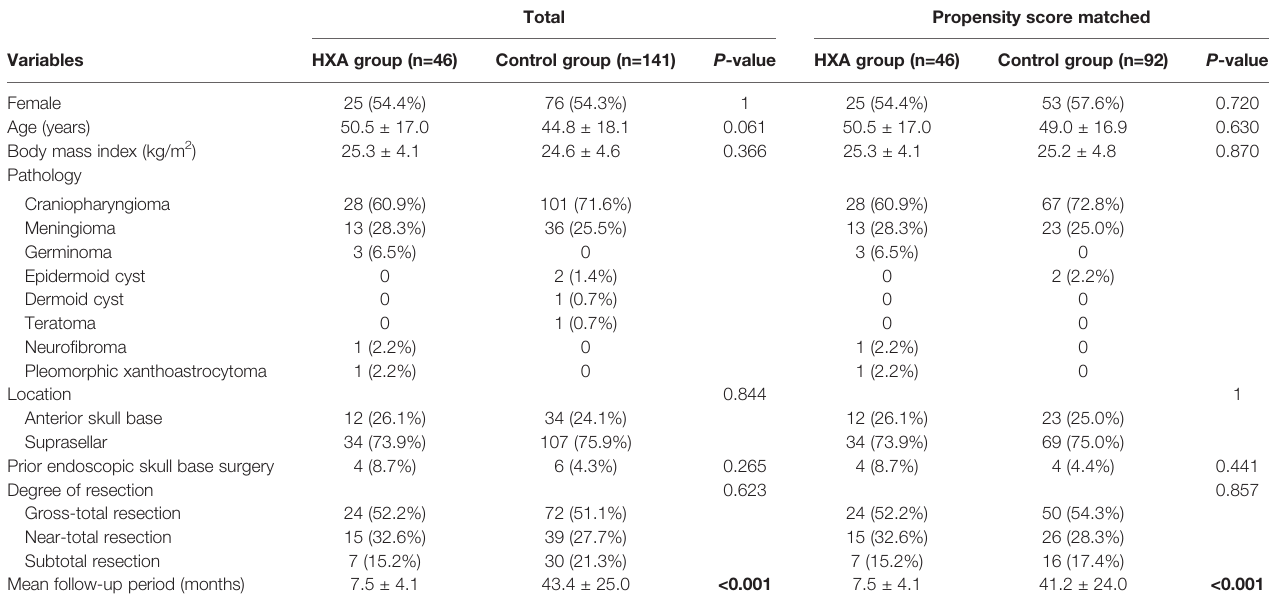
TABLE 1 | Demographic, disease, and surgical characteristics of